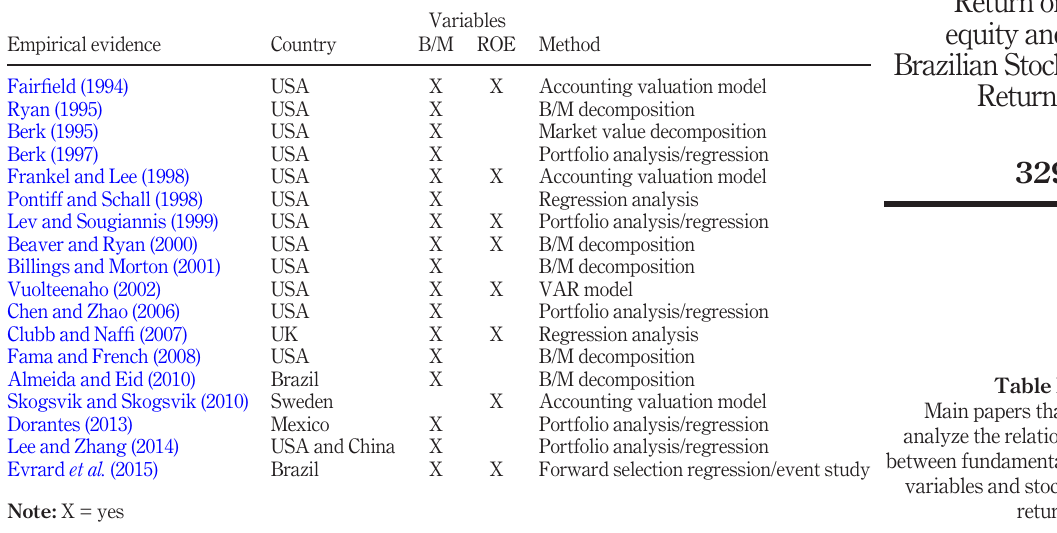
analyze the relation between fundamental variables and stock